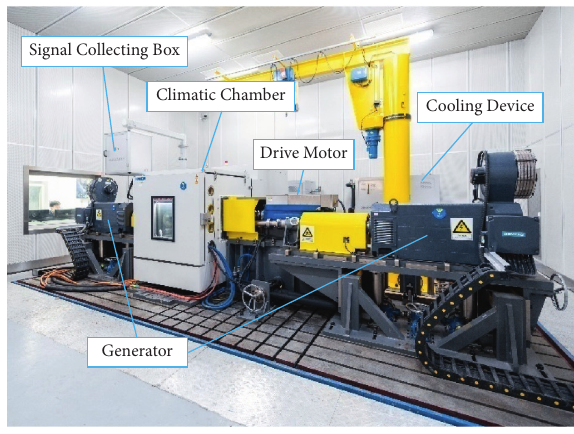
Figure 3: Triaxial reducer test bed. Table 1: Parameters of vibration